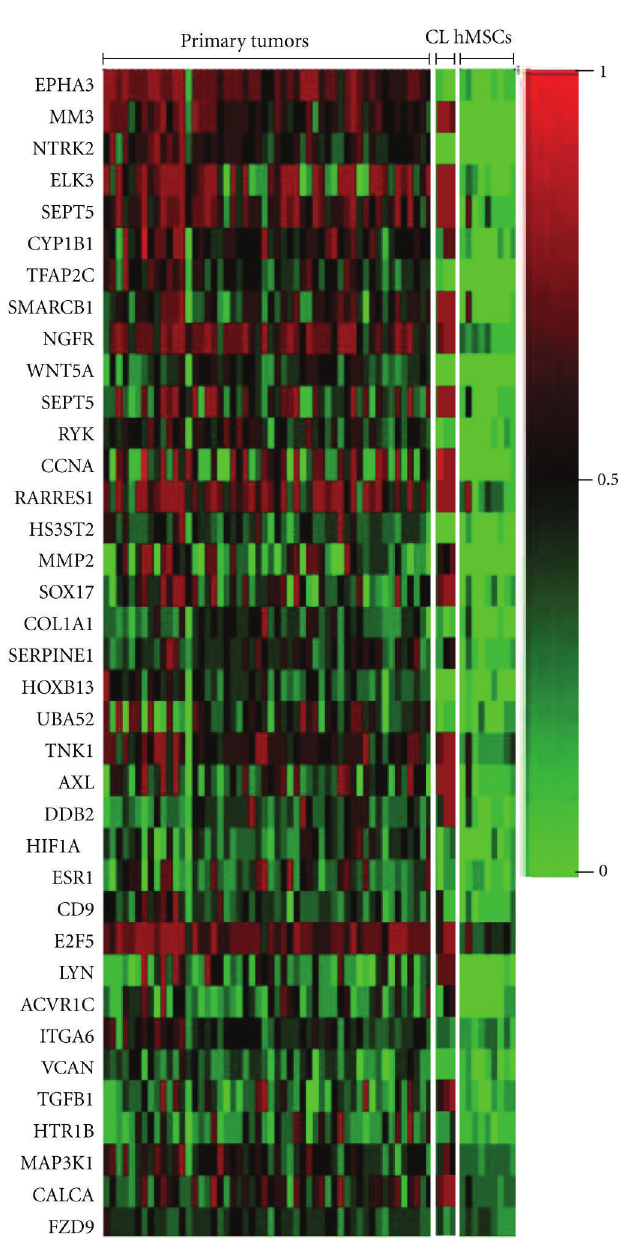
Figure 2: Heat map depicting DNA hypermethylation in EWS primary tumors. 37 CpGs in 36 genes were found to be hypermethylated in > 30% of EWS primary tumors ( n = 52) and > 75% of hMSCs ( N = 8). Also shown are methylation analyses of EWS cell lines A673, SK-N-MC, and SK-ES-1, respectively. Red: methylated; green: unmethylated, CL: cell